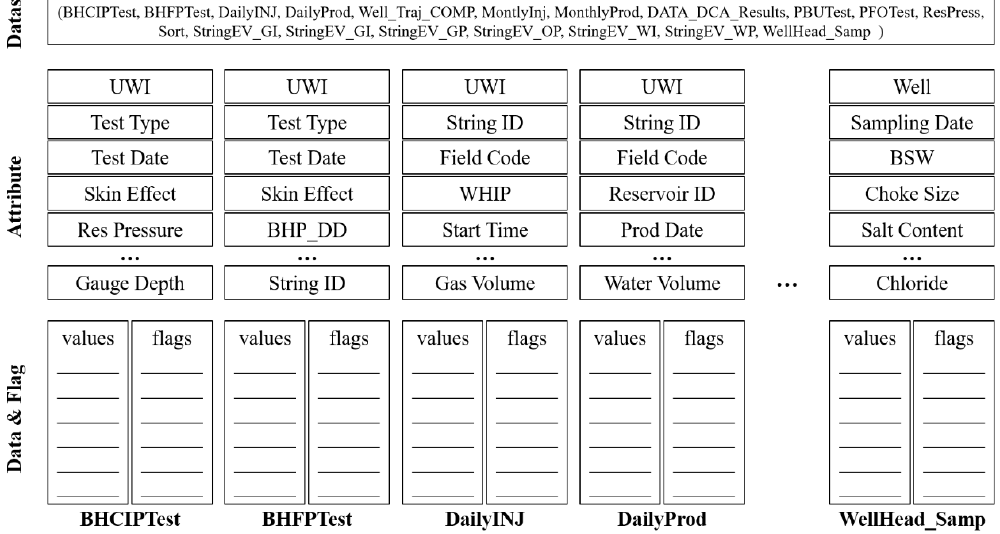
Figure 3. Data structure with multiple sources and attributes.